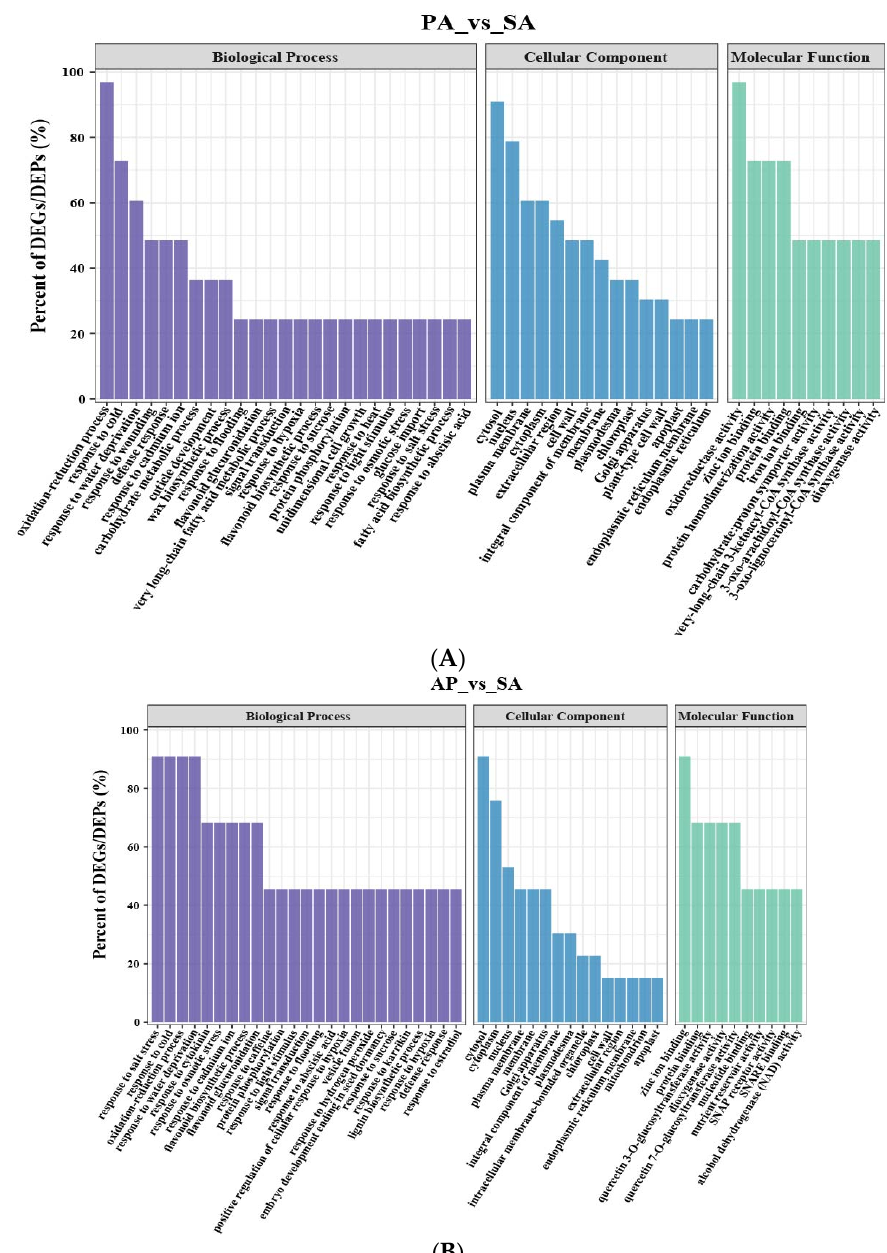
Figure 6. GO term analysis of differentially expressed genes (DEGs) and differentially expressed proteins (DEPs) in grafted apricot hybrids. ( A ) DEGs/DEPs enriched in GO terms in peach/apricot (PA); ( B ) DEGs/DEPs enriched in GO terms in apricot/peach (AP).